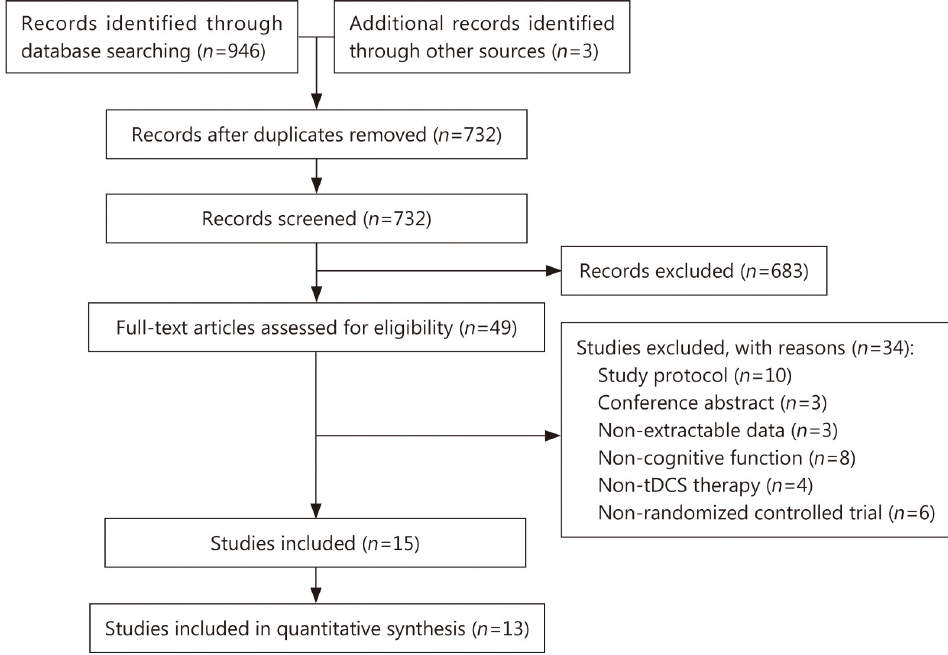
Fig 1. PRISMA flow